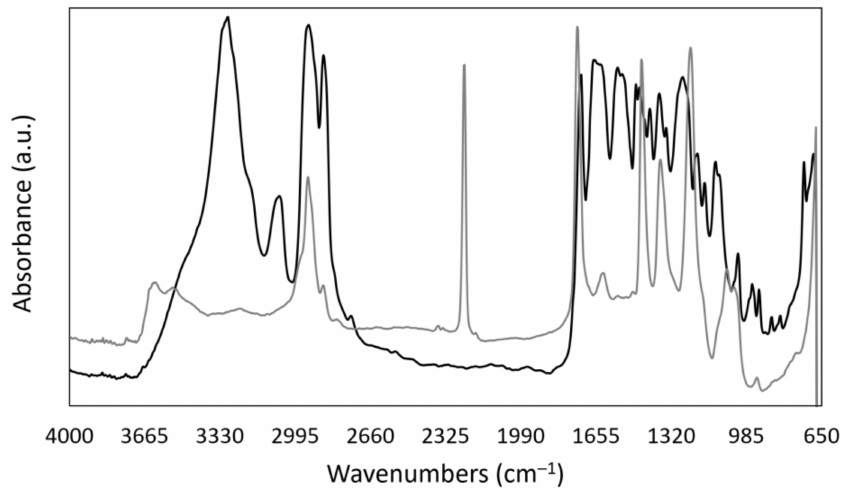
Figure 6. Representative FTIR spectrum of synthetic fibers (black spectrum: polyamide; grey spec- trum: polyacrylonitrile). A total of 20 randomly selected fibers from a purified sample were analyzed.